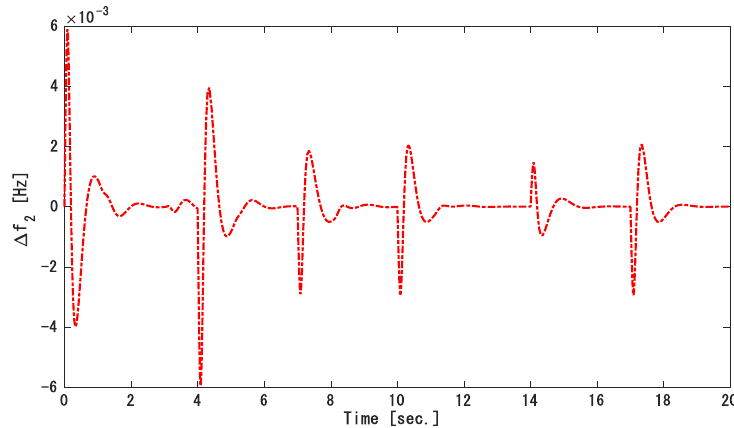
Figure 15. The frequency variation of 2nd area.